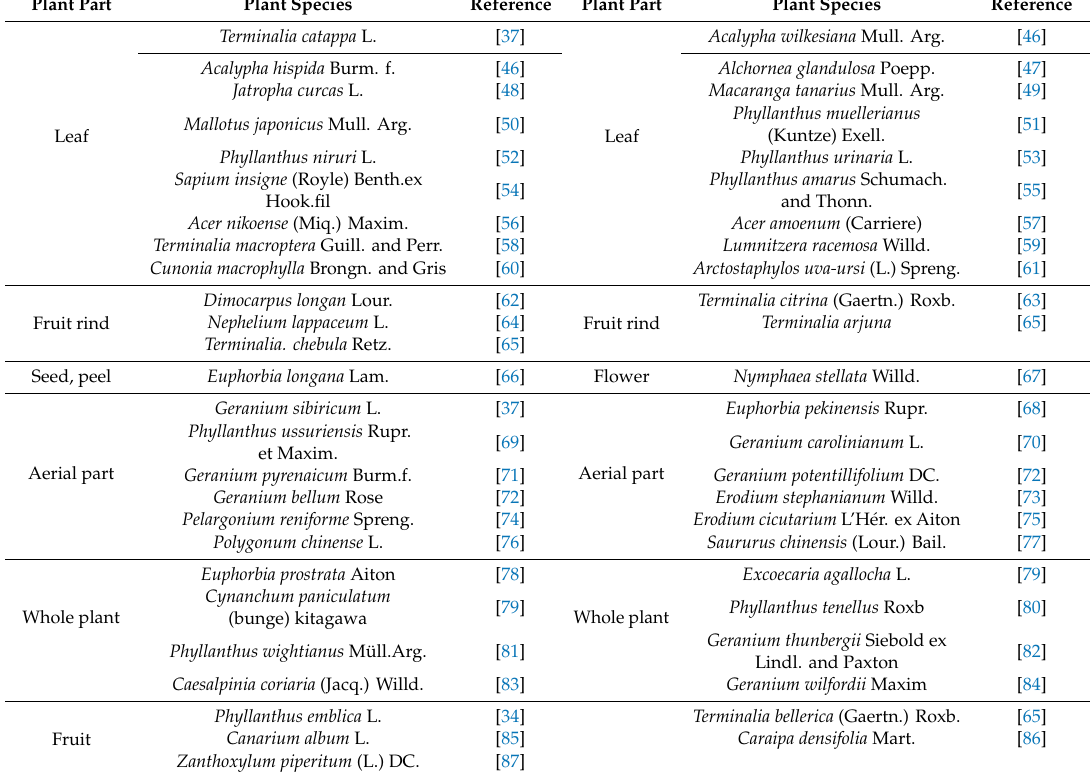
Table 1. Distribution of corilagin in diverse plant